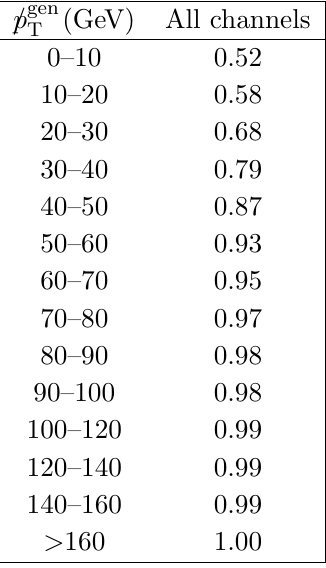
requirement in all channels versus p gen T